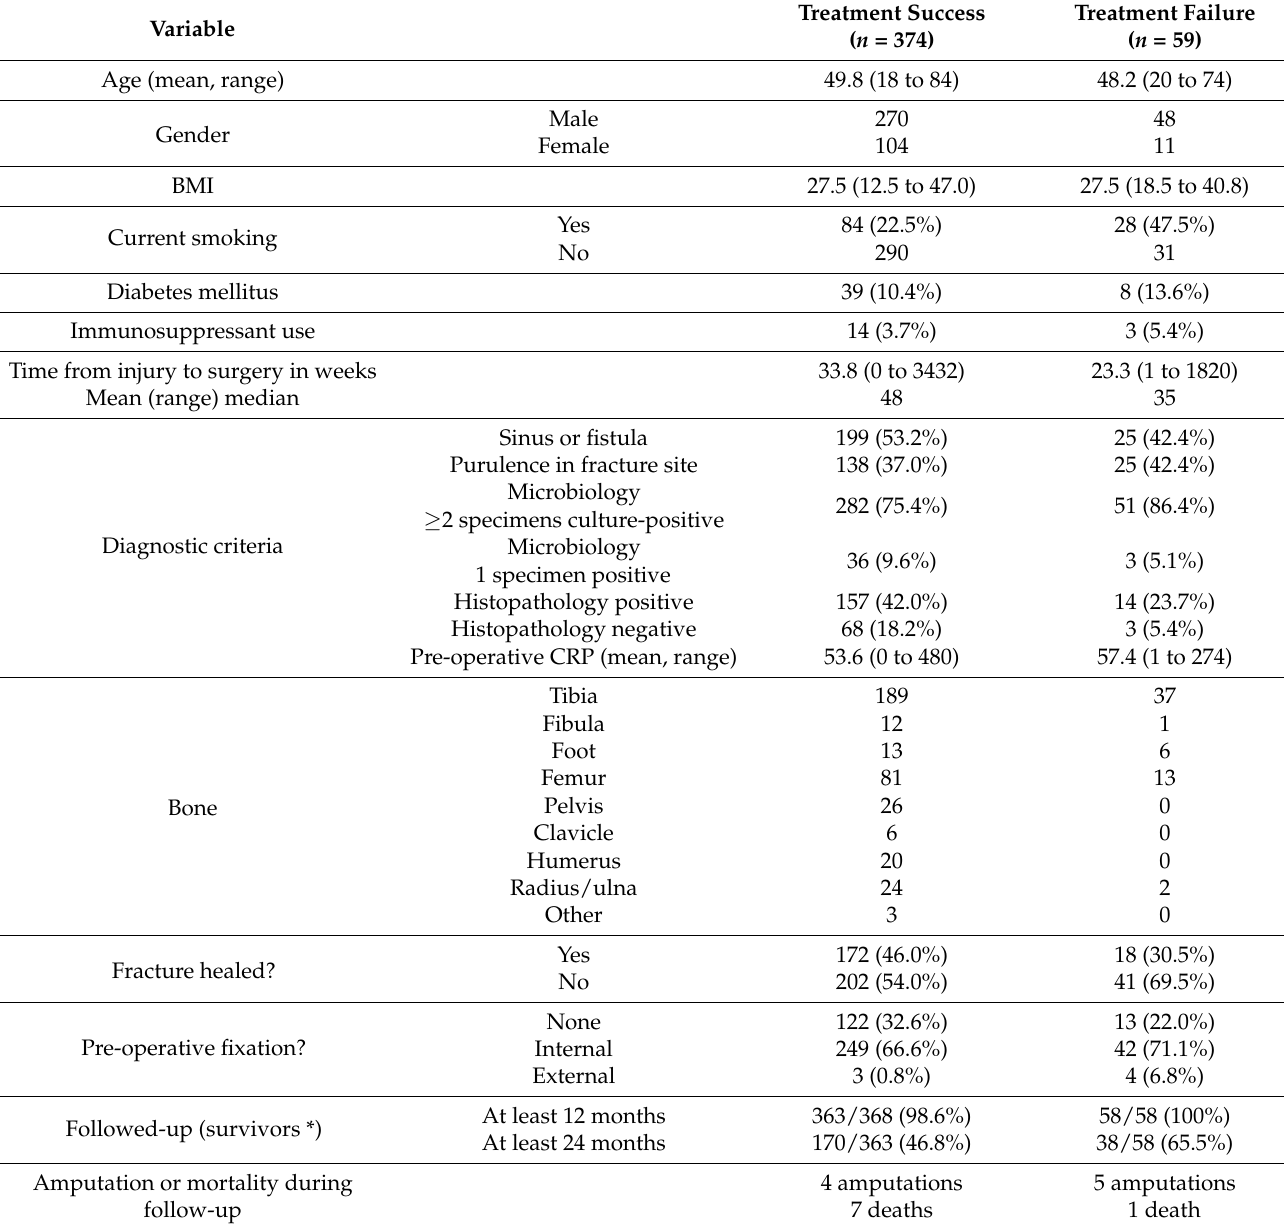
Table 1. Patient demographics related to treatment